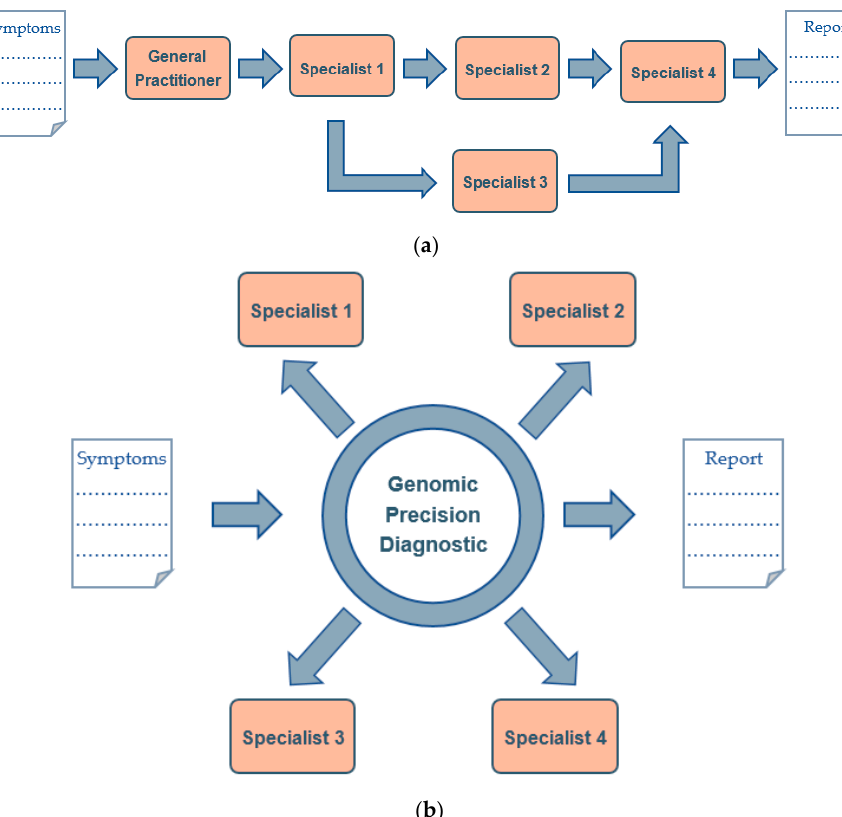
Figure 2. Classic genetic diagnostic ( a ) vs. Genomic diagnostic ( b ) flow-charts: Genomic Precision